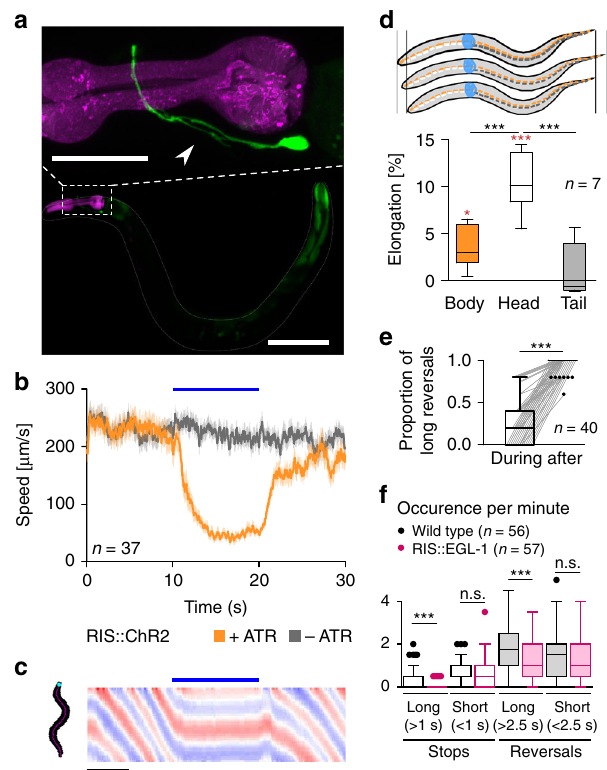
Fig. 1 Photo-depolarization of the RIS neuron inhibits locomotion. a Maximum intensity projection showing single-cell GFP expression in RIS. The pharynx expressing mCherry is shown in magenta. Scale bar = 100 µ m. Inset: Enlarged head region. Arrowhead: RIS axonal branch region. Scale